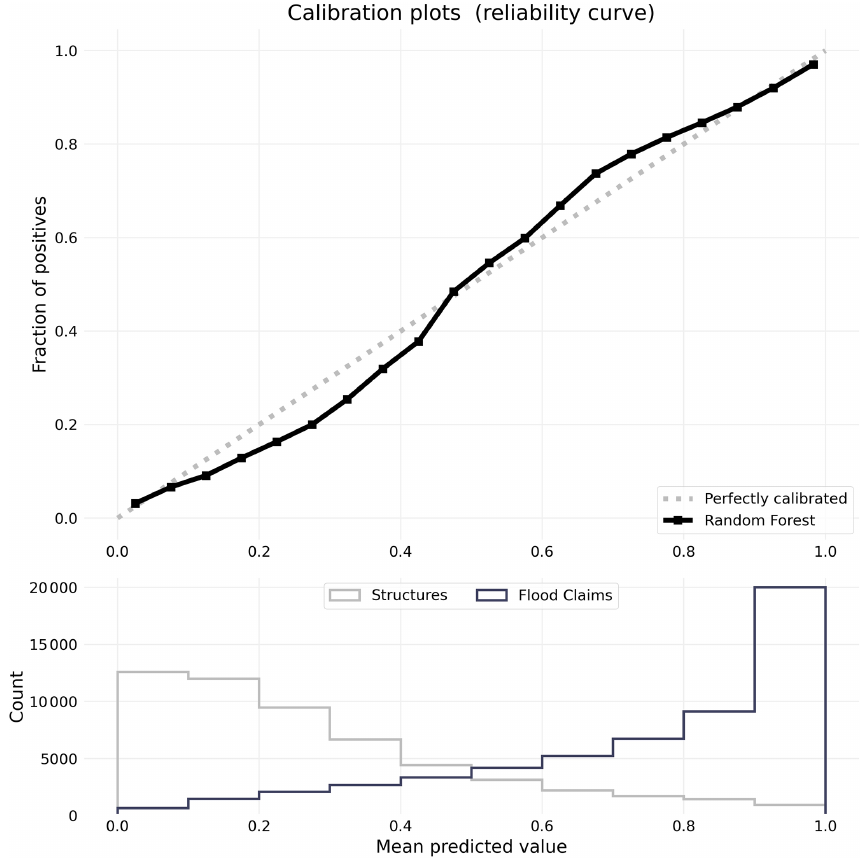
Figure 5. Calibration plot (top) with histogram of flooded and non-flooded samples and their predicted values. Table 2. Represents the number of structures with at least a 1.0% or 0.2% probability of flooding within the modeled flood hazard and the SFHA. Layer Probability Study area Lake Conroe Houston (Meyerland) Port Arthur Flood hazard